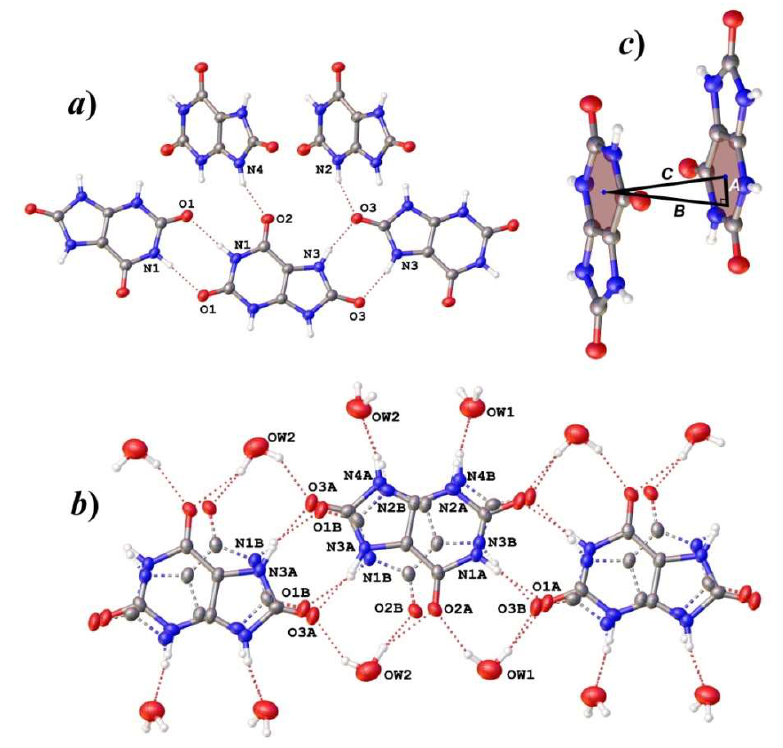
Figure 3. An arrangement of uric acid molecules in chains in the structures of ( a ) UA and ( b ) UAD; ( c ) parallel-displaced π -stacking between the pyrimidine cycles. See Table 2 for details. Legend the same as in Figure 2.